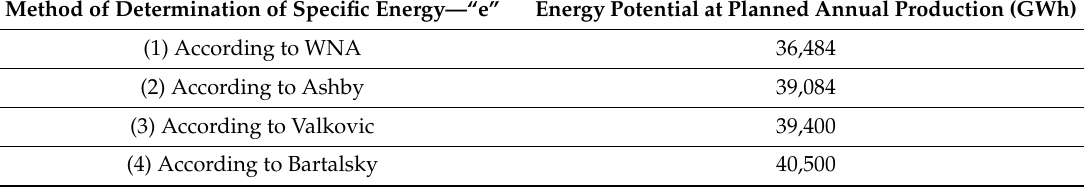
Table 7. The energy potential at planned annual mining production at the deposit of